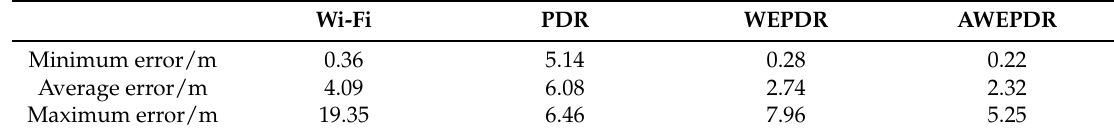
Table 3. Error analysis of different indoor positioning